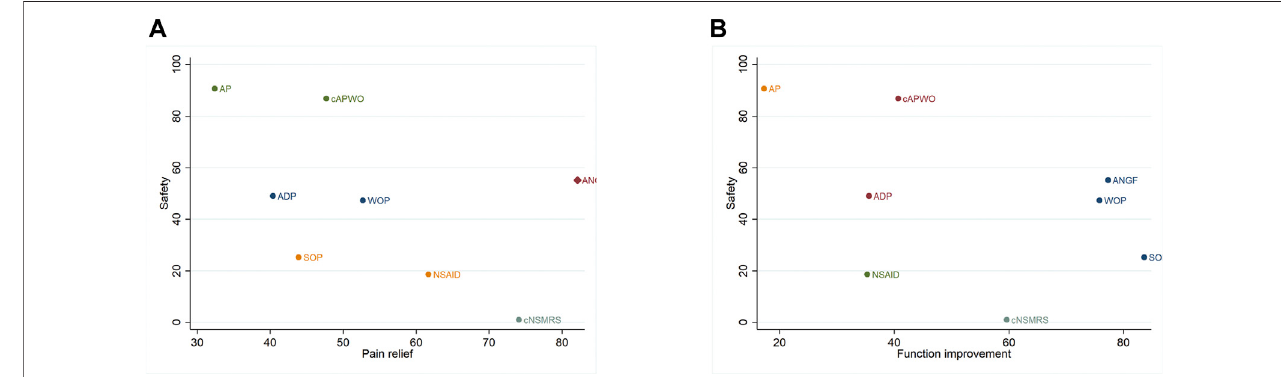
FIGURE 3 | Cluset-rank plots of main analysis. Clustering for treatments of a network of interventions according to their performance on two outcomes, and the interventionclosertotheupperrightperformedbetter. (A) Thecluster-rankplotofpainreliefandsafety. (B) Thecluster-rankplotoffunctionimprovementandsafety(The cluster-rank value is the product of the abscissa and ordinate of each